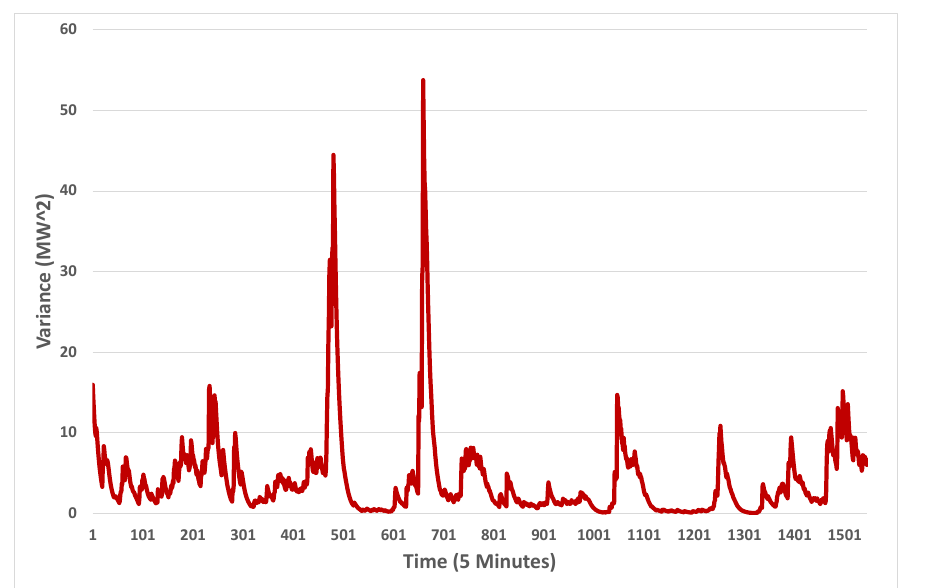
Figure 3. Exponentially weighted moving variance. Time is in 5 min intervals.